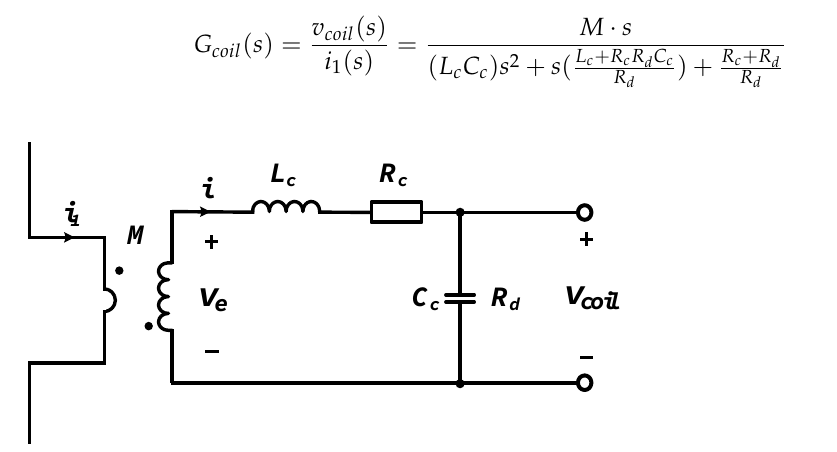
Figure 2. Lumped circuit of the pickup coil.